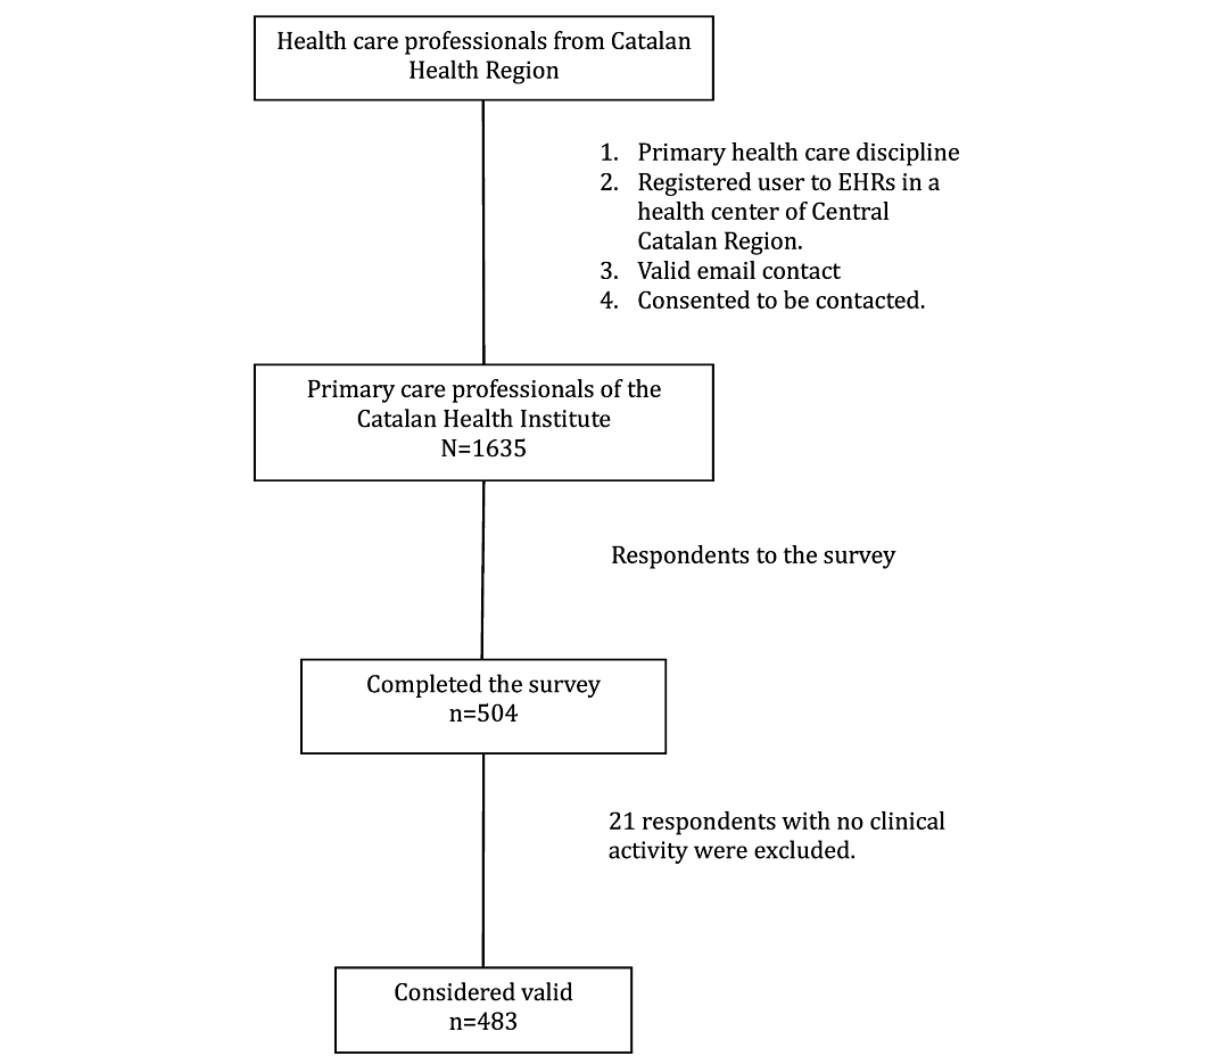
Figure 1. Flow of participants through the study. EHR: electronic health